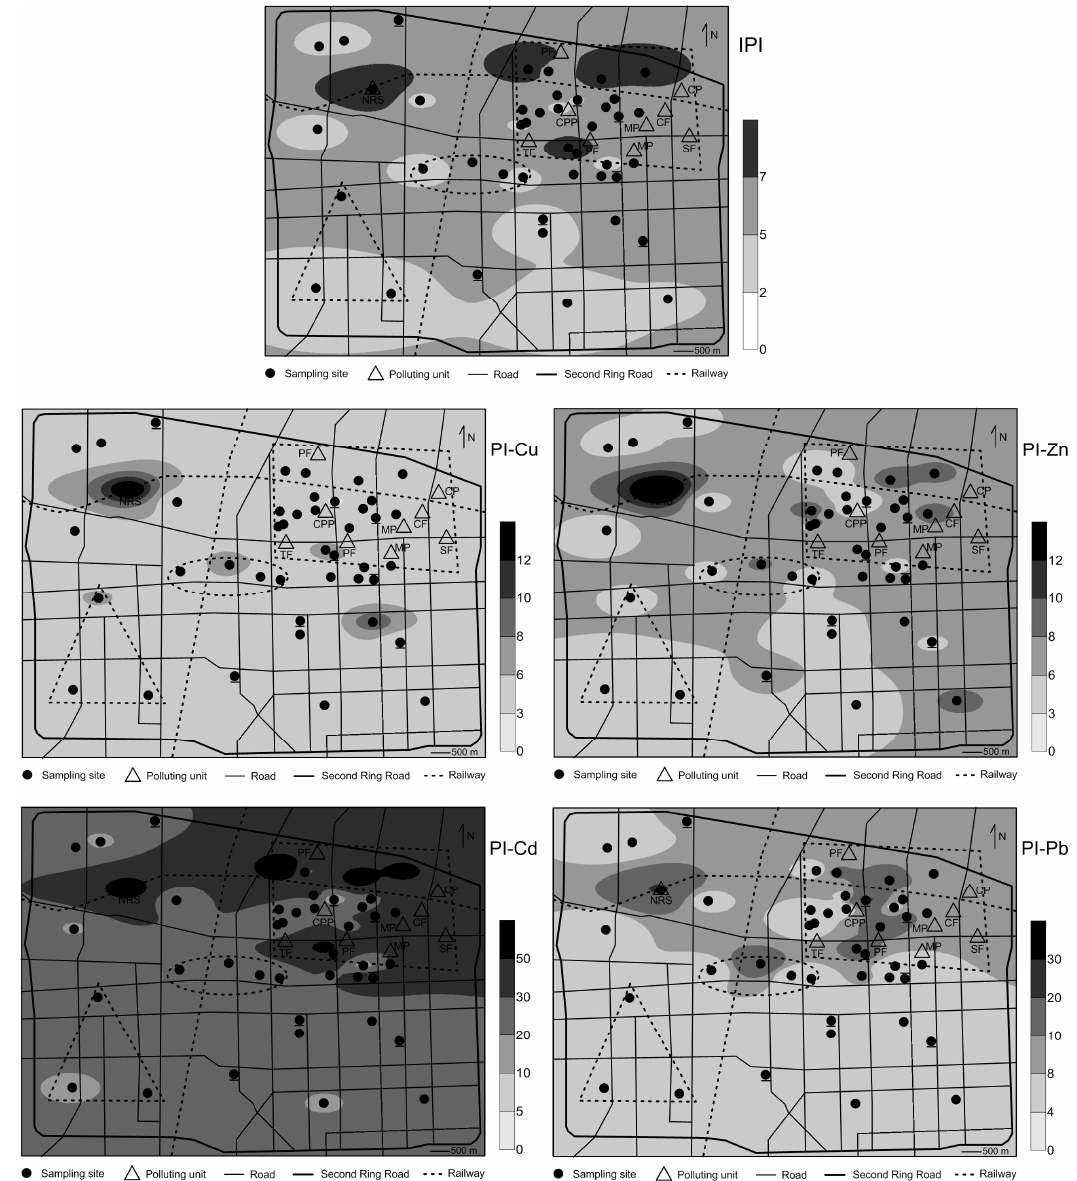
Figure 5. Spatial distributions for the integrated pollution indexes (IPIs) of the ten heavy metals and pollution indexes (PIs) of the four heavily polluted metals (Cu, Zn, Cd, and Pb) in the settled dust over the Shijiazhuang main urban area.